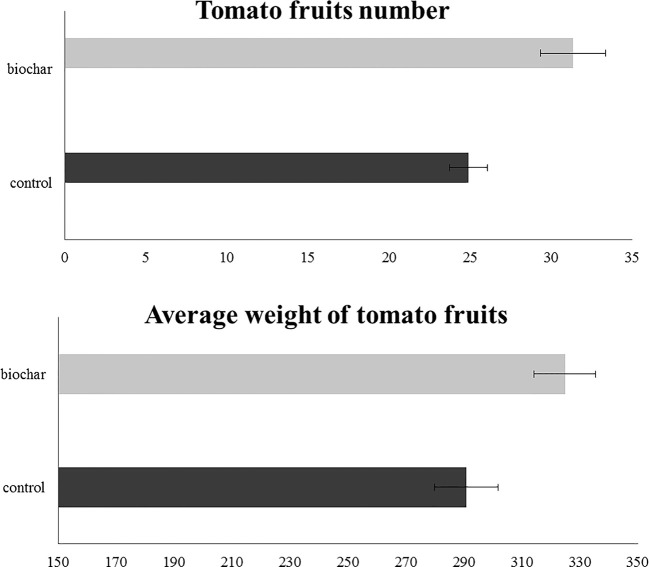
Fruit characteristics in tomato plants experiencing low-input farming conditions in soils amended with or not with 5% Verfofood biochar. (A) Average number of fruits per plant at the end of the experiment. (B) Average weight of the fully-ripen fruits. Measurements were performed at the end of plant treatment using one sample per five pots.